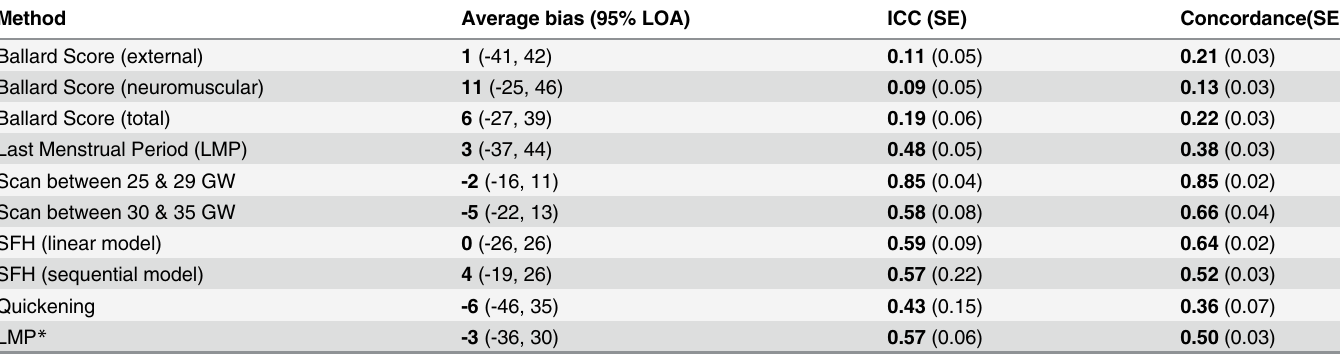
Table 3. Comparison of Clinical and Late Ultrasound Estimates of Gestational Age Against Reference